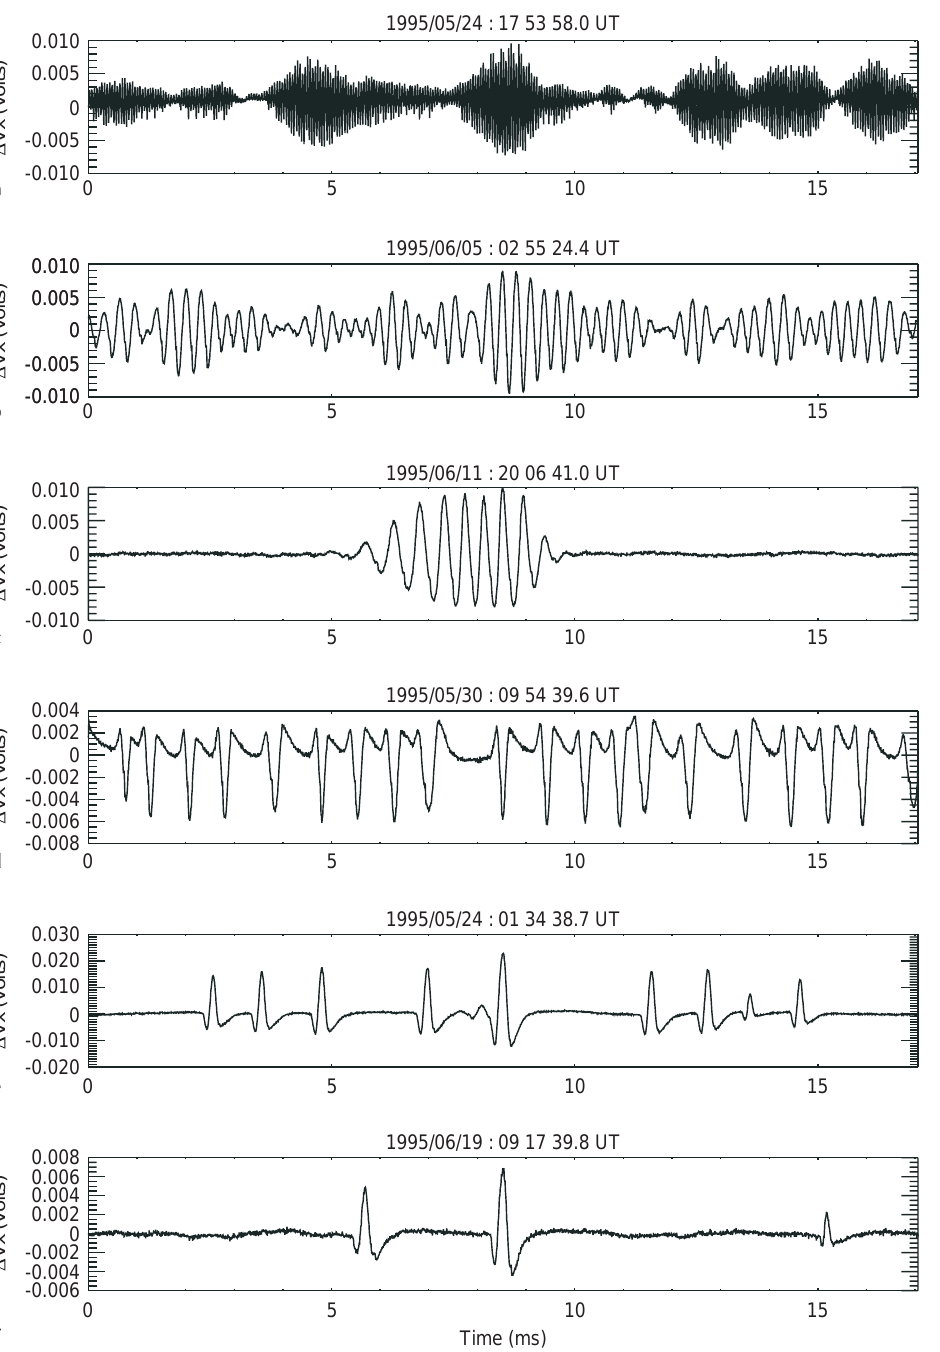
Fig. 1a–f. Six typical wave forms observed by the TDS in the solar wind. The electric potential D V x in volts is mea- sured at the terminals of the x - antenna, L x (cid:136) 50 m. a Langmuir waves; b and c low